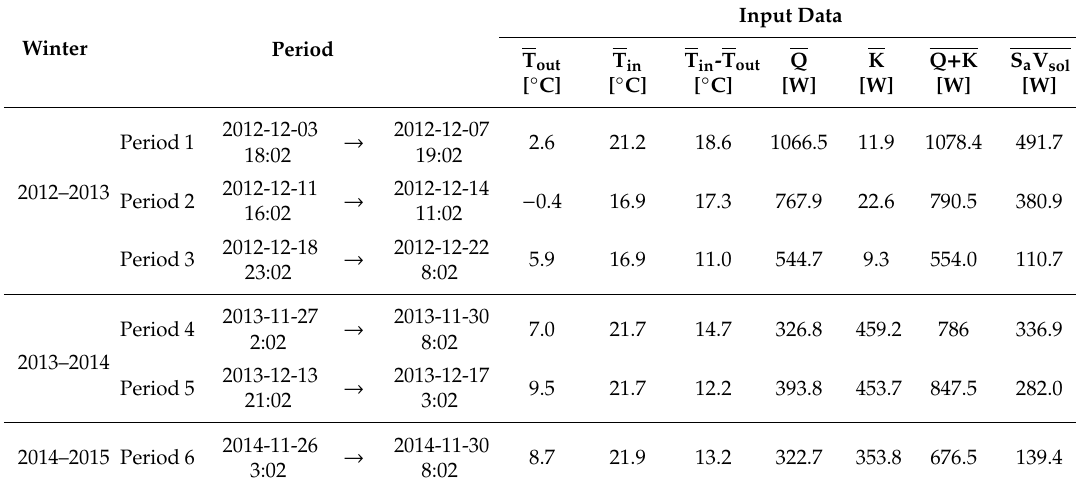
Table 3. NecessaryperiodaveragedvariablevaluestoestimatetheHLC simple (simple Heat Loss Coe ffi cient) and HLC (Heat Loss Coe ffi cient) for Gainsborough. The variables included are the outdoor temperature (T out ), the indoor temperature (T in ), the temperature di ff erence (T in − T out ), the space heating heat input (Q), the electrical heat gains (K), the internal heat gains (Q + K) and the solar gains (S a V sol ).